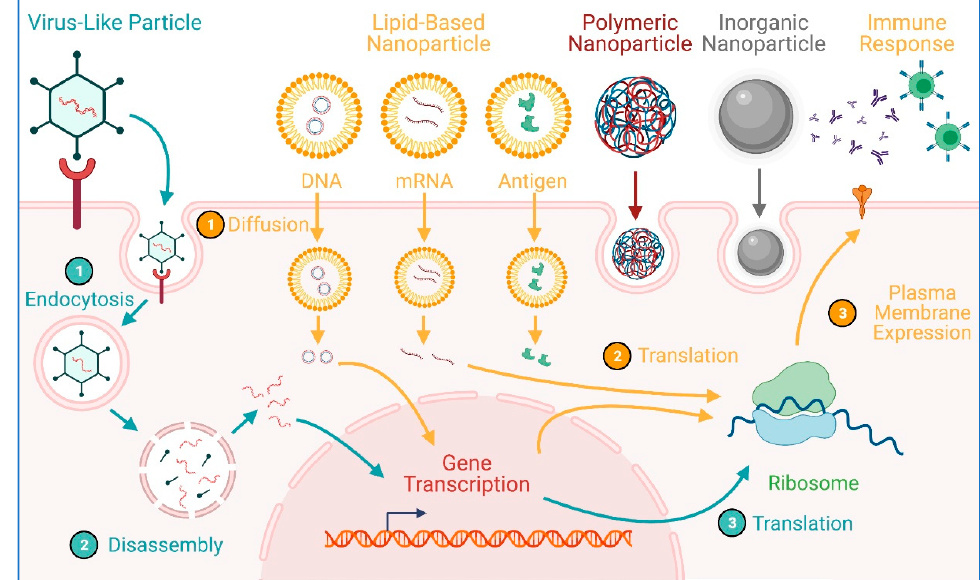
Figure 3. Potential applications of nanoparticles in the development of COVID-19 vaccines. Fig- ure generated using